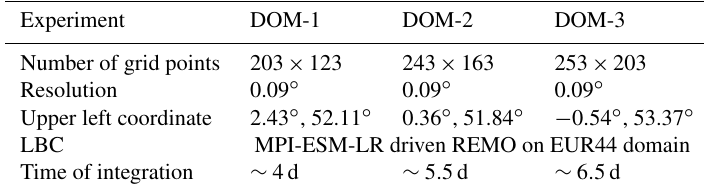
Table 1. The main parameters and settings of selected test domains.